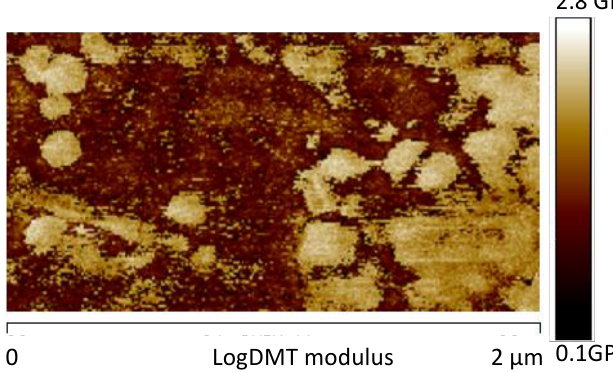
Figure 14. AFM image of the logDMT modulus maps of the sample 0GNPs (550).